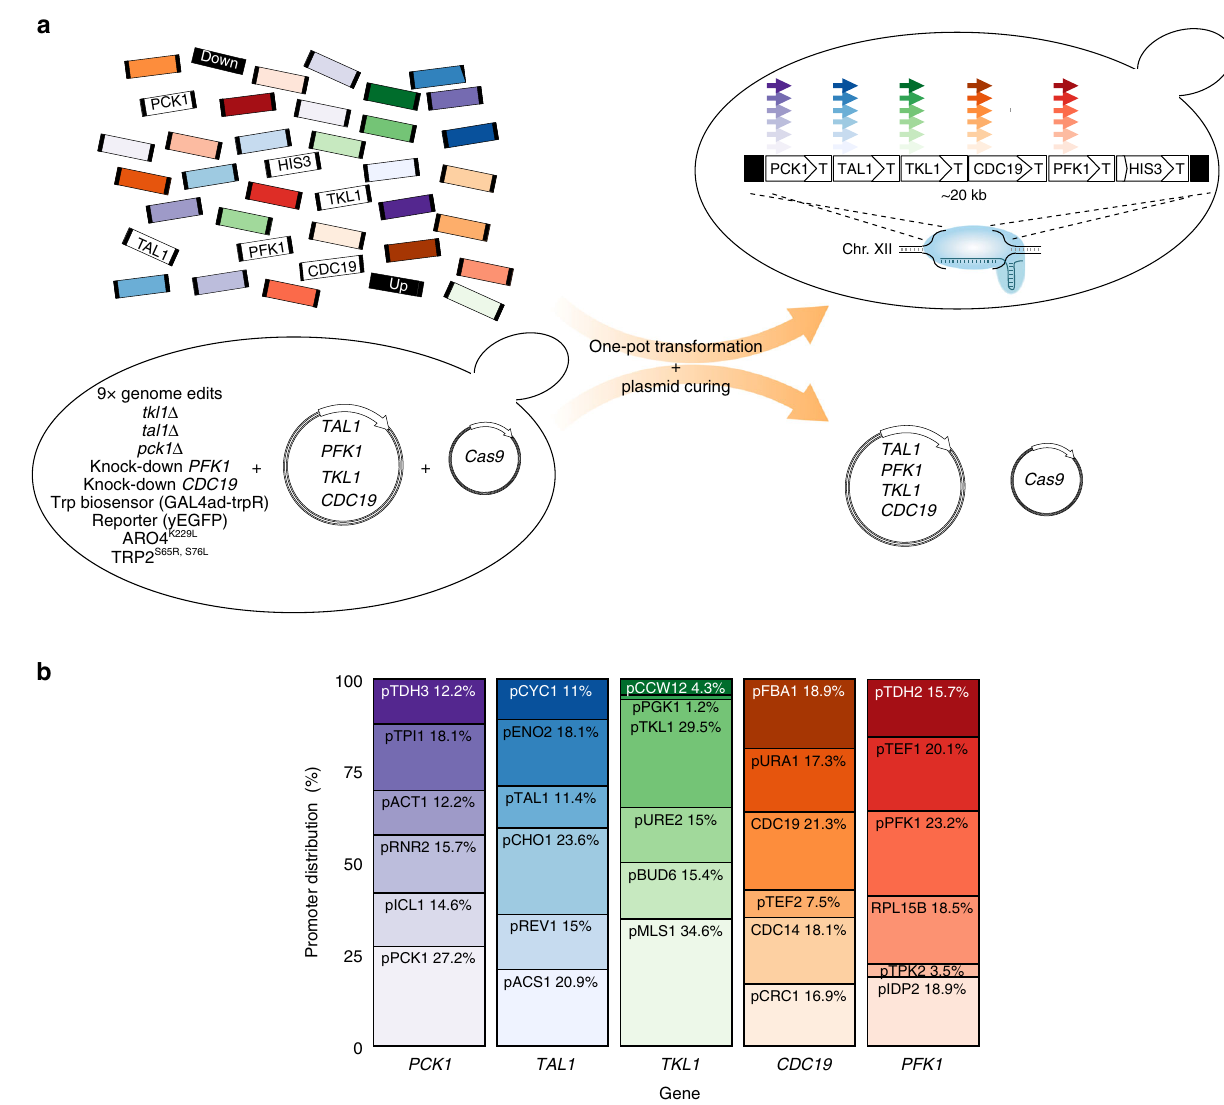
Fig. 2 Construction and validation of the 13-parts assembled 20 kb combinatorial promoter:gene library. a Strategy for library construction including a 13-part in vivo assembly for the reintegration of target genes into a single genomic locus. The platform strain used for one-pot transformation includes a total of nine genome edits for knockout, knockdown, and heterologous expression of candidate genes (see “ Methods ” section). yEGFP yeast-enhanced green fl uorescent protein. b Promoter distribution (name, % representation) by gene. Color intensity correlates with promoter strength (see Fig. 1d). Source data underlying Fig. 2b are provided as a Source data fi le. Table 1 Key descriptive statistics for the library construction and